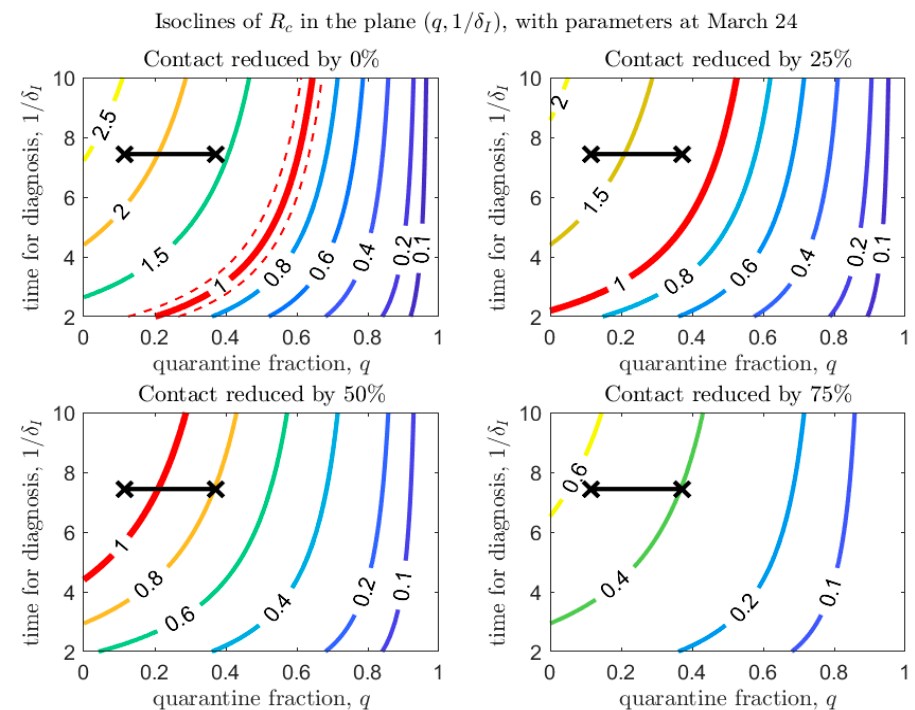
Figure 4. Values of R c in the plane ( q ,1/ δ I ) , with baseline parameters estimated on March 24 (top-left panel), and under di ff erent scenarios of contact rate reduction (other panels). The red line corresponds to R c = 1 (with dashed lines showing confidence intervals in the baseline scenario). The black crosses correspond to the parameters (max / min) estimated after March 24 (last day of the estimation period is April 21).